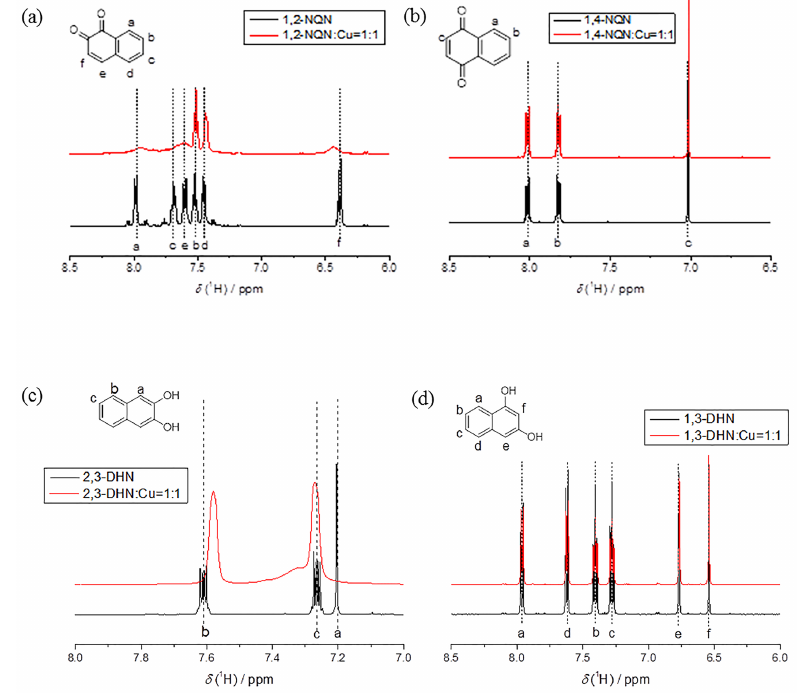
Figure 10. 1-D 1 H-NMR spectra of (a) 1,2-NQN, (b) 1,4-NQN, (c) 2,3-DHN, and (d) 1,3-DHN, and their mixture with 1:1 ratio of Cu (II). Both 1,2-NQN and 2,3-DHN show the broadening of 1 H-NMR peaks (protons at a, c, e, f and a, b, c for 1,2-NQN and 2,3-DHN, respectively) after mixing with Cu (II).